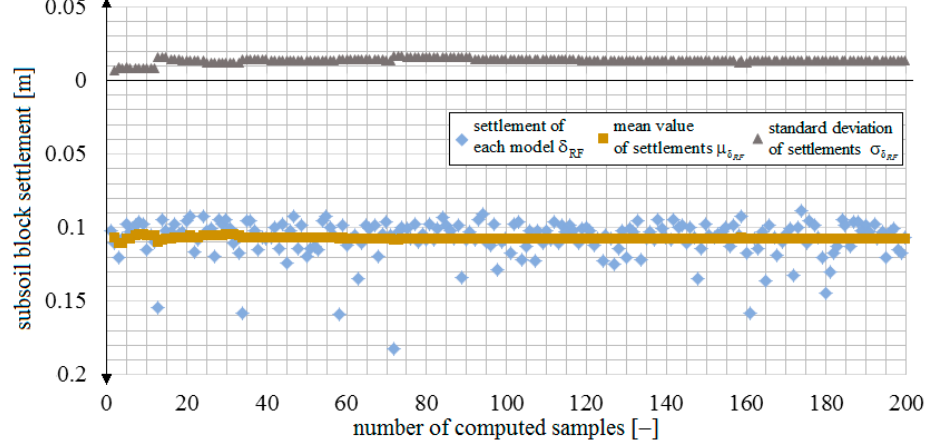
Figure 4. Convergence of simulation-based settlement estimation, the random field model, d = 0.01 m − 1 .